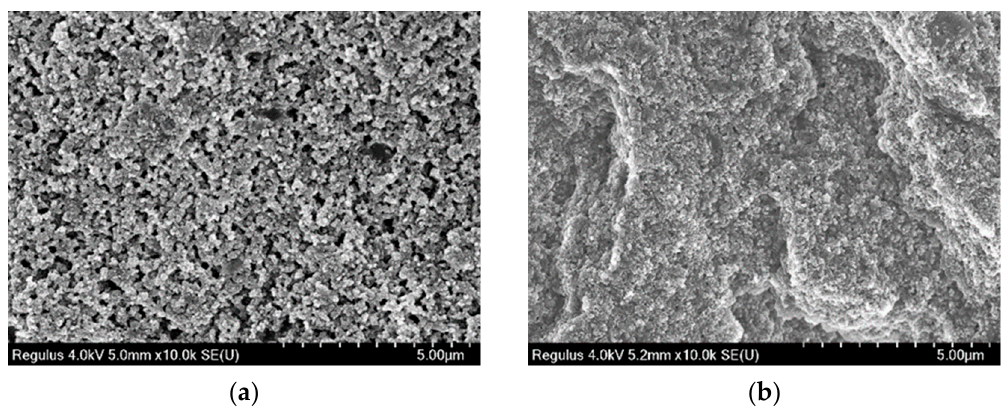
Figure 13. SEM images of NR section specimen (WCB 90–120 phr, magnification 10,000×). ( a ) EG 2–90 phr; ( b ) EG 2–120 phr.